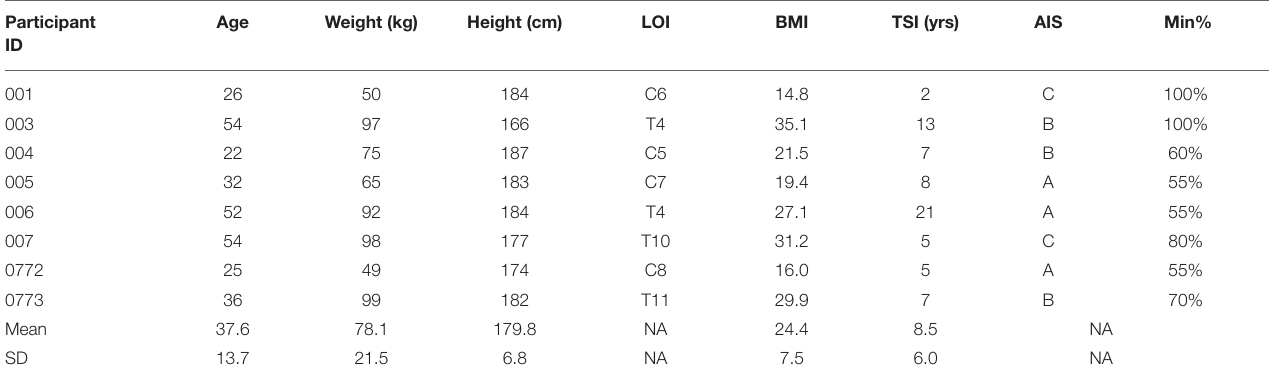
TABLE 1 | Participant characteristics enrolled in the current trial. Participant